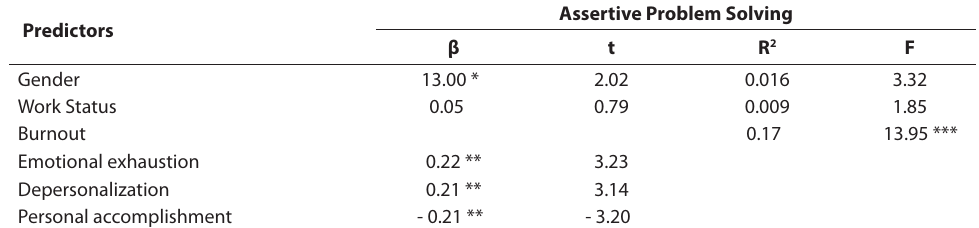
TABLE 3 Regression analysis of the Assertive Problem Solving from gender, work status and MBI-GS questionnaire factors